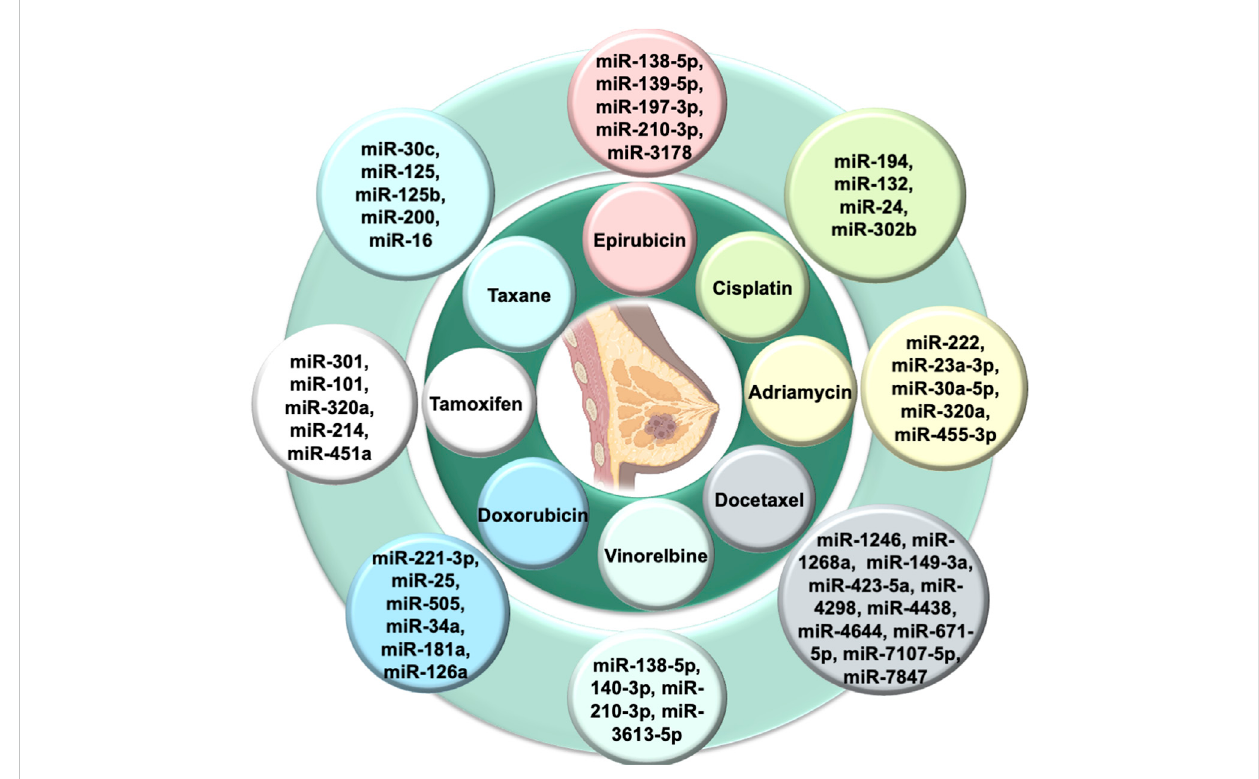
FIGURE 2 Exosomal miRNAs in chemoresistance of breast cancer.